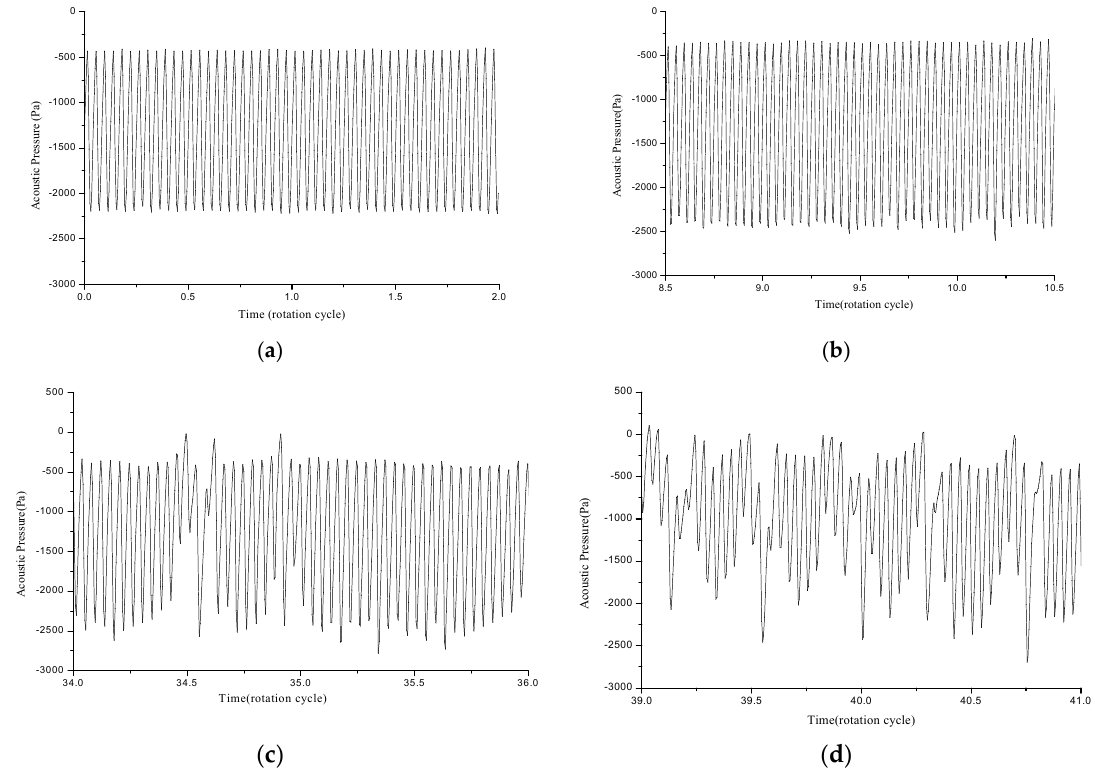
Figure 9. The time domain characteristic of acoustic pressure at monitoring points A: ( a ) the design condition; ( b ) near the stall inception condition; ( c ) stall inception condition; and ( d ) the mature stall cell condition.